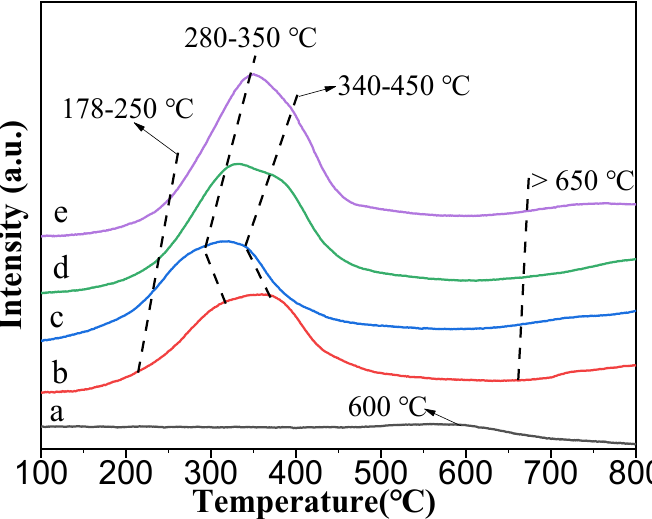
Figure 4. H 2 -TPR curves of prepared catalysts ( a : M-TSO; b : MnCeO x /M-TSO; c : K 0.1 MnCeO x /M-TSO; d : K 0.5 MnCeO x /M-TSO; e : K 1 MnCeO x /M-TSO).